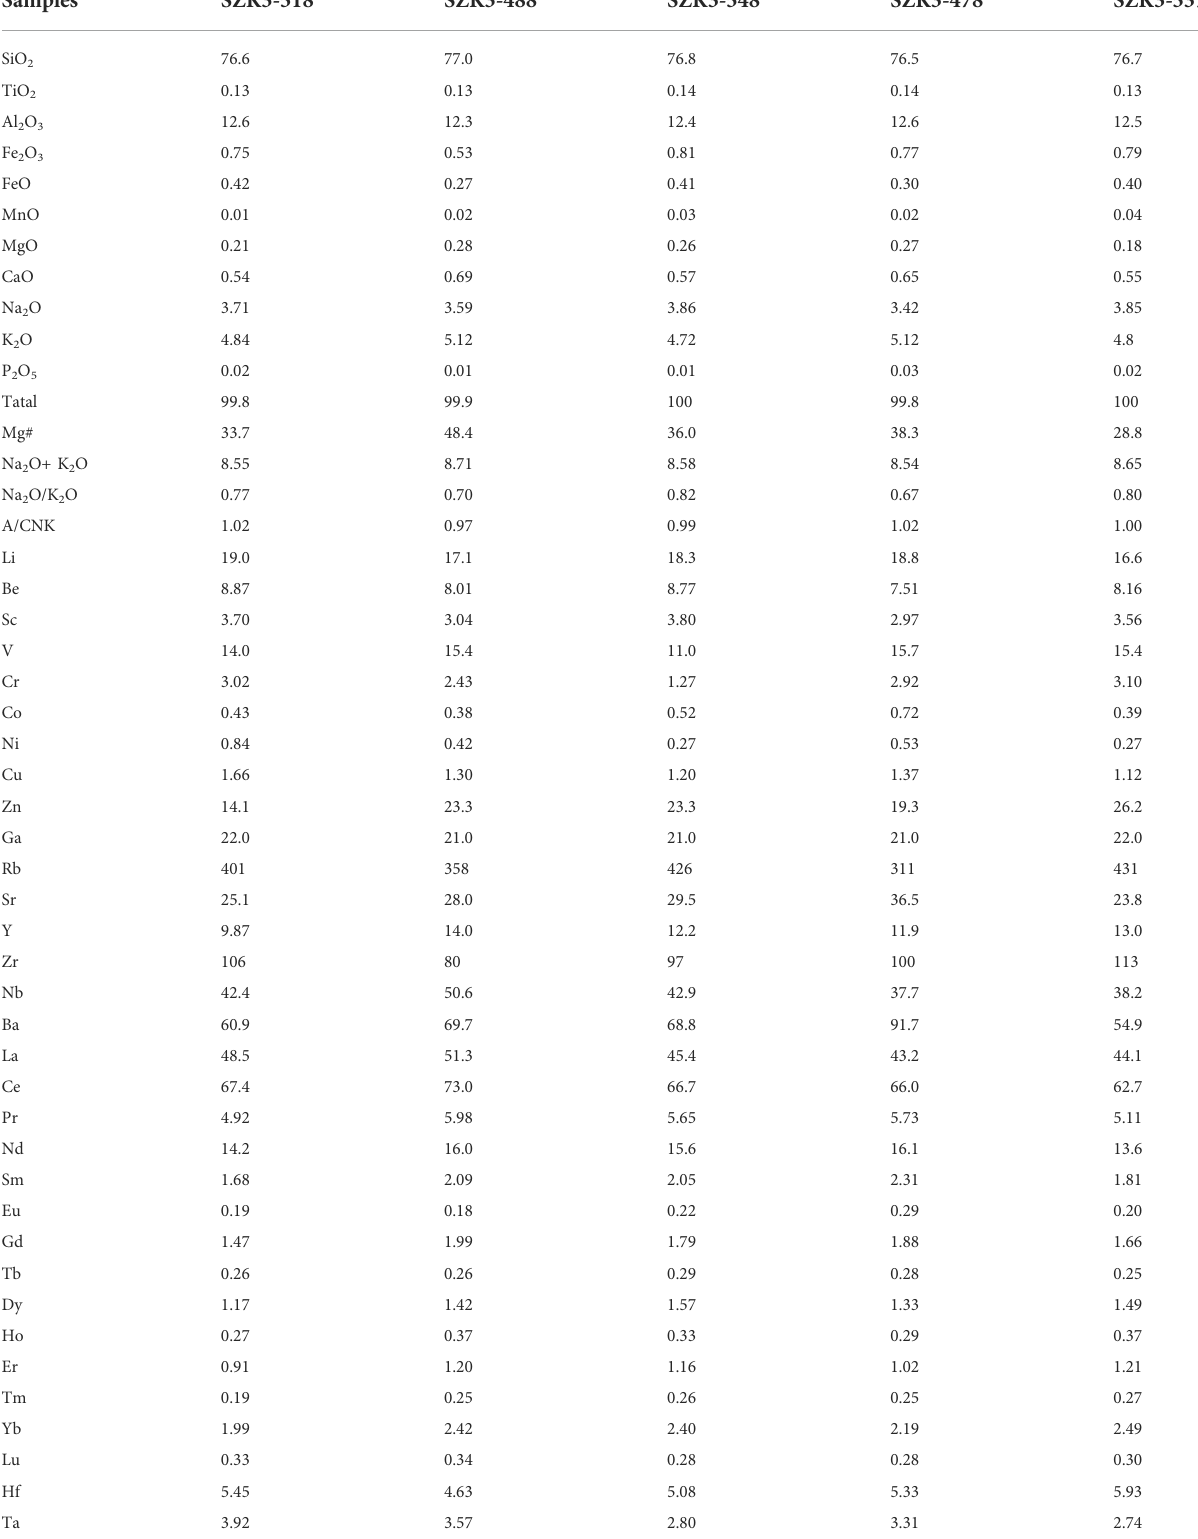
TABLE 2 Major and trace element data for alkali-feldspar granite from the Shanagen hydrothermal vein-type Mo deposit.